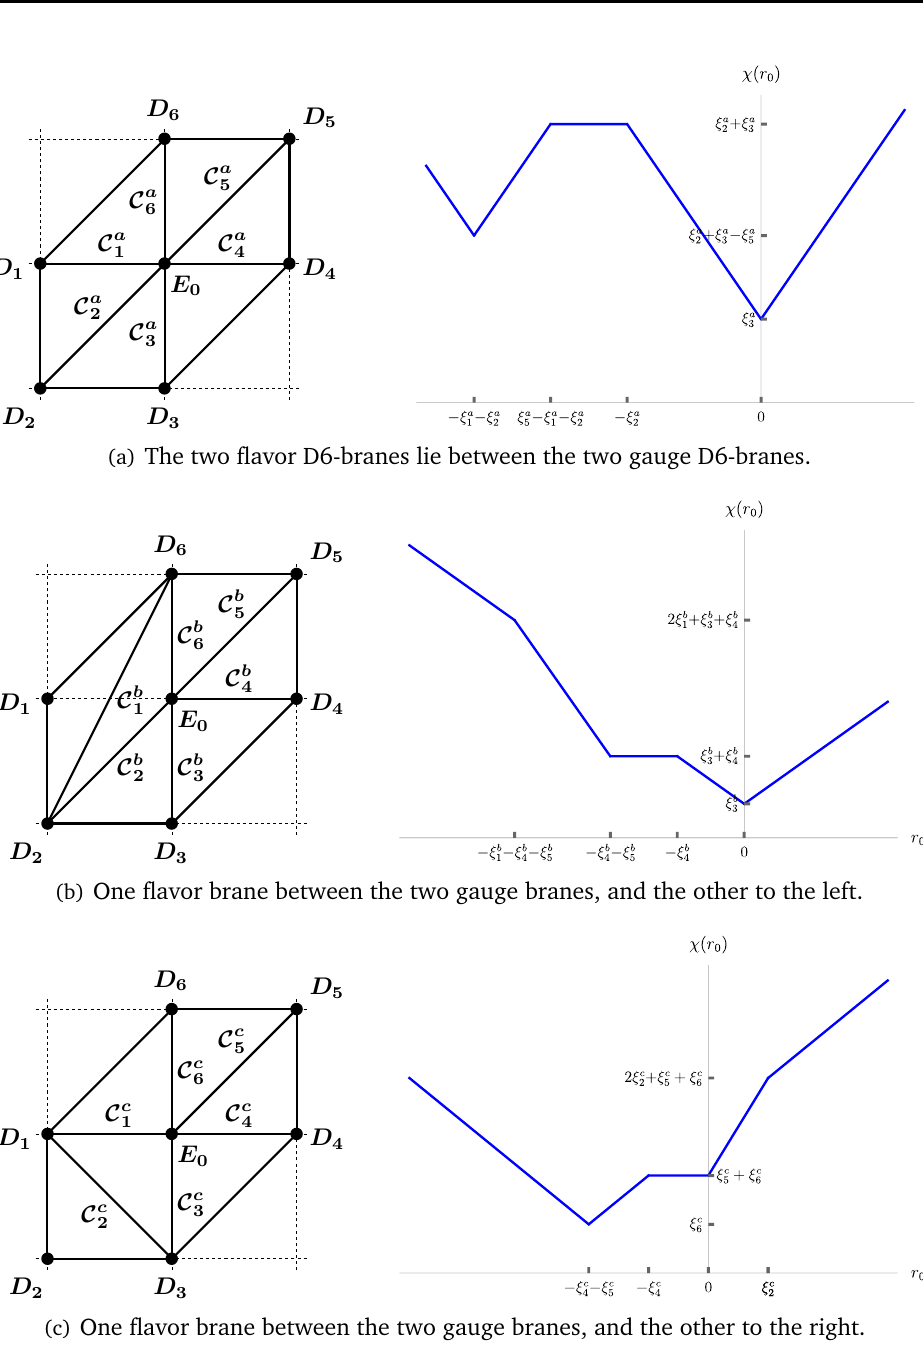
singularity and their 3